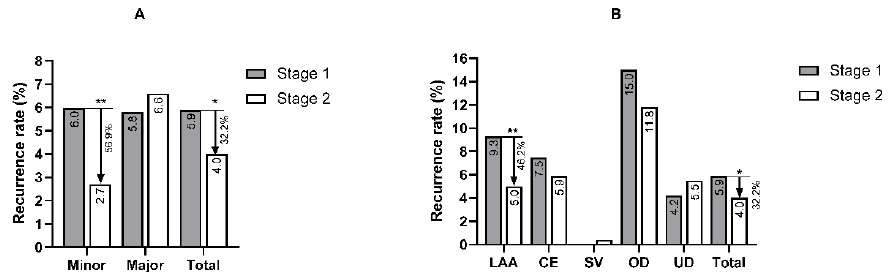
Figure 3. The recurrence rate in patients with different stroke severities ( A ) and TOAST subtypes ( B ). TOAST, Trial of Org 10172 in Acute Stroke Treatment; Minor, minor stroke (NIHSS score ≤ 3 points); Major, major stroke (NIHSS > 3 points); AA, artery atherosclerosis; CE, cardio-aortic embo- lism; SV, small vessel disease; OD, other determined causes; UD, undetermined causes. The levels of significance ( p ) in each subgroup were equal to 0.025 (0.05/2) in Figure 2A and 0.01 (0.05/5) in Figure 2B. *—significant difference ( p < 0.05), **—significant difference ( p < 0.01).